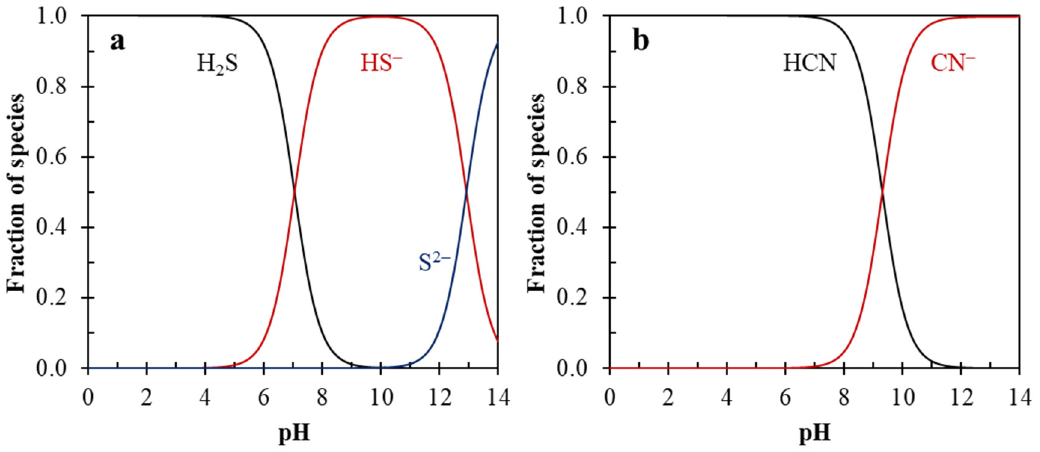
Figure 4. pH-dependent speciation of ( a ) sulfide (p K a1 = 7.1 and p K a2 = 12.9; [S] tot = 1 M) and ( b ) cyanide (p K a = 9.3; [CN] tot = 1 M).